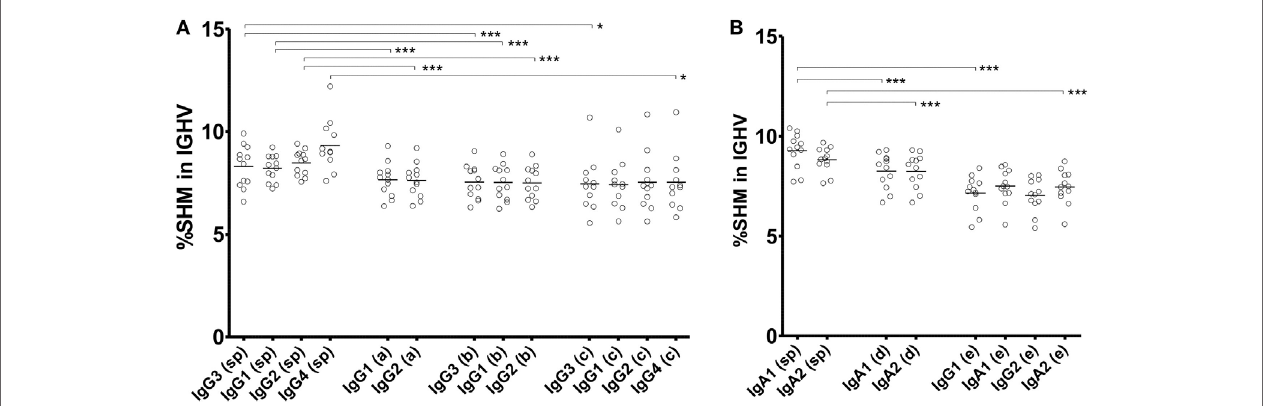
FigUre 7 | somatic hypermutation (shM) levels of subclass-specific and shared clones in igg (a) and iga (B) subclasses . The frequencies of SHM within the immunoglobulin (Ig) variable region (IGHV) in subclass-specific clones and clones shared among multiple subclasses are shown. Sequence reads found in only an Ig subclass were considered as subclass-specific clones (sp). SHM levels in sequence reads shared between IgG1 and IgG2 (double, a); among IgG3, IgG1 and IgG2 (triple, b); among IgG3, IgG1, IgG2, and IgG4 (quadruple, c); between IgA1 and IgA2 (double, d); and among IgG1, IgA1, IgG2, and IgA2 (quadruple, e) were compared. Statistical significance was tested by Wilcoxon rank-sum test (* P < 0.05, ** P < 0.01, and *** P <